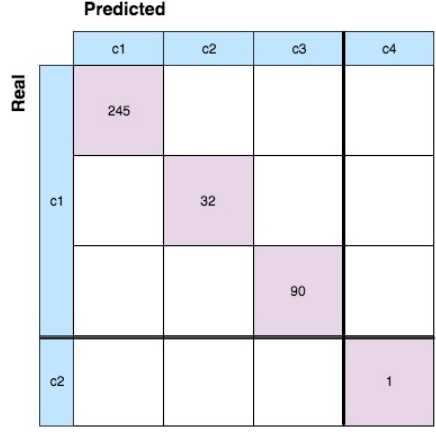
Figure 13. Dynamic degradation modelling and RUL prediction triggered at defined AT. Table 2. Comparison of the state space model (SSM) performance with different input parameter sets.